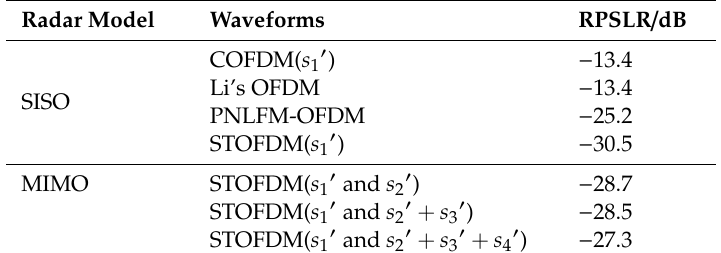
Table 6. Range peak sidelobe ratios (RPSLR) of previous and designed STOFDM signals in single input single output (SISO) and MIMO